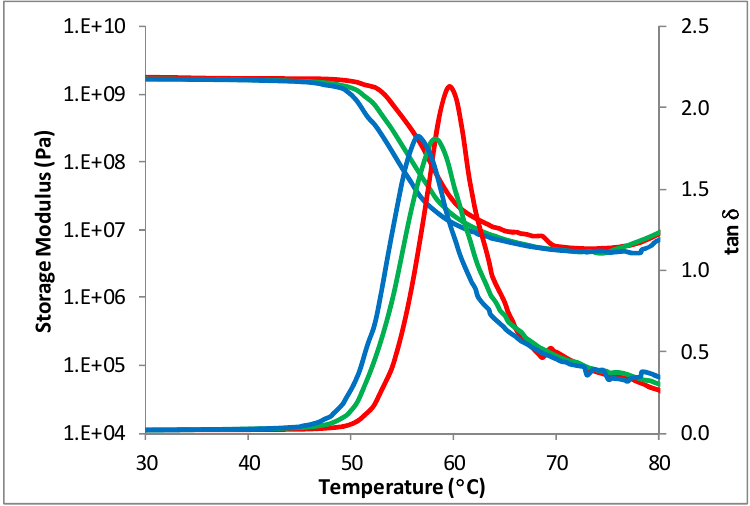
Figure 8. DMTA of PLA modified with 10% loadings of tannin hexanoate and tannin hexanoate acetate. PLA (red), TanHex (green) and TanHexAc